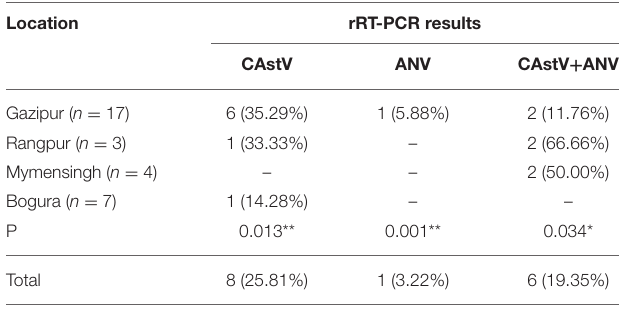
Brazil (MK929649.1 is 99.45% with Brazilian KR013276.1) and India (MK929650.1 is 99.18% with Indian